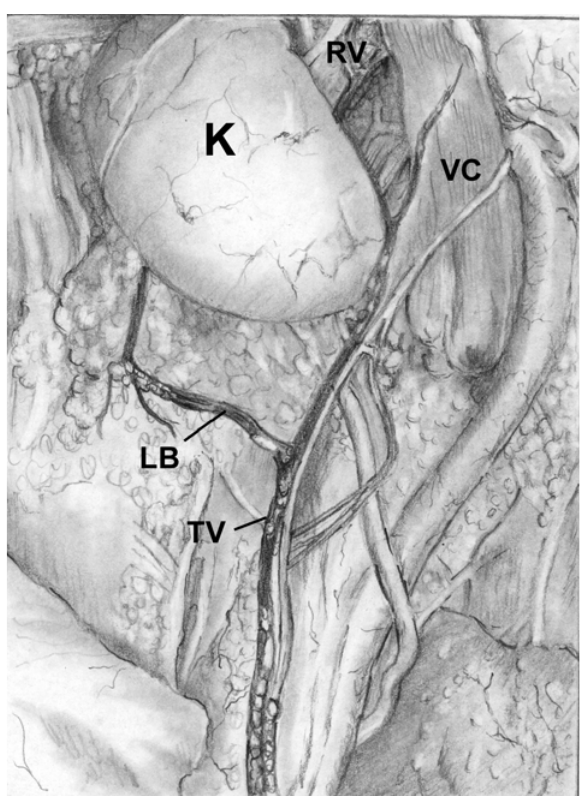
Figure 2 – Schematic drawing highlights the division of the tes- ticular vein, originating a lateral branch (LB). VC = inferior vena cava, RV = right renal vein; K =